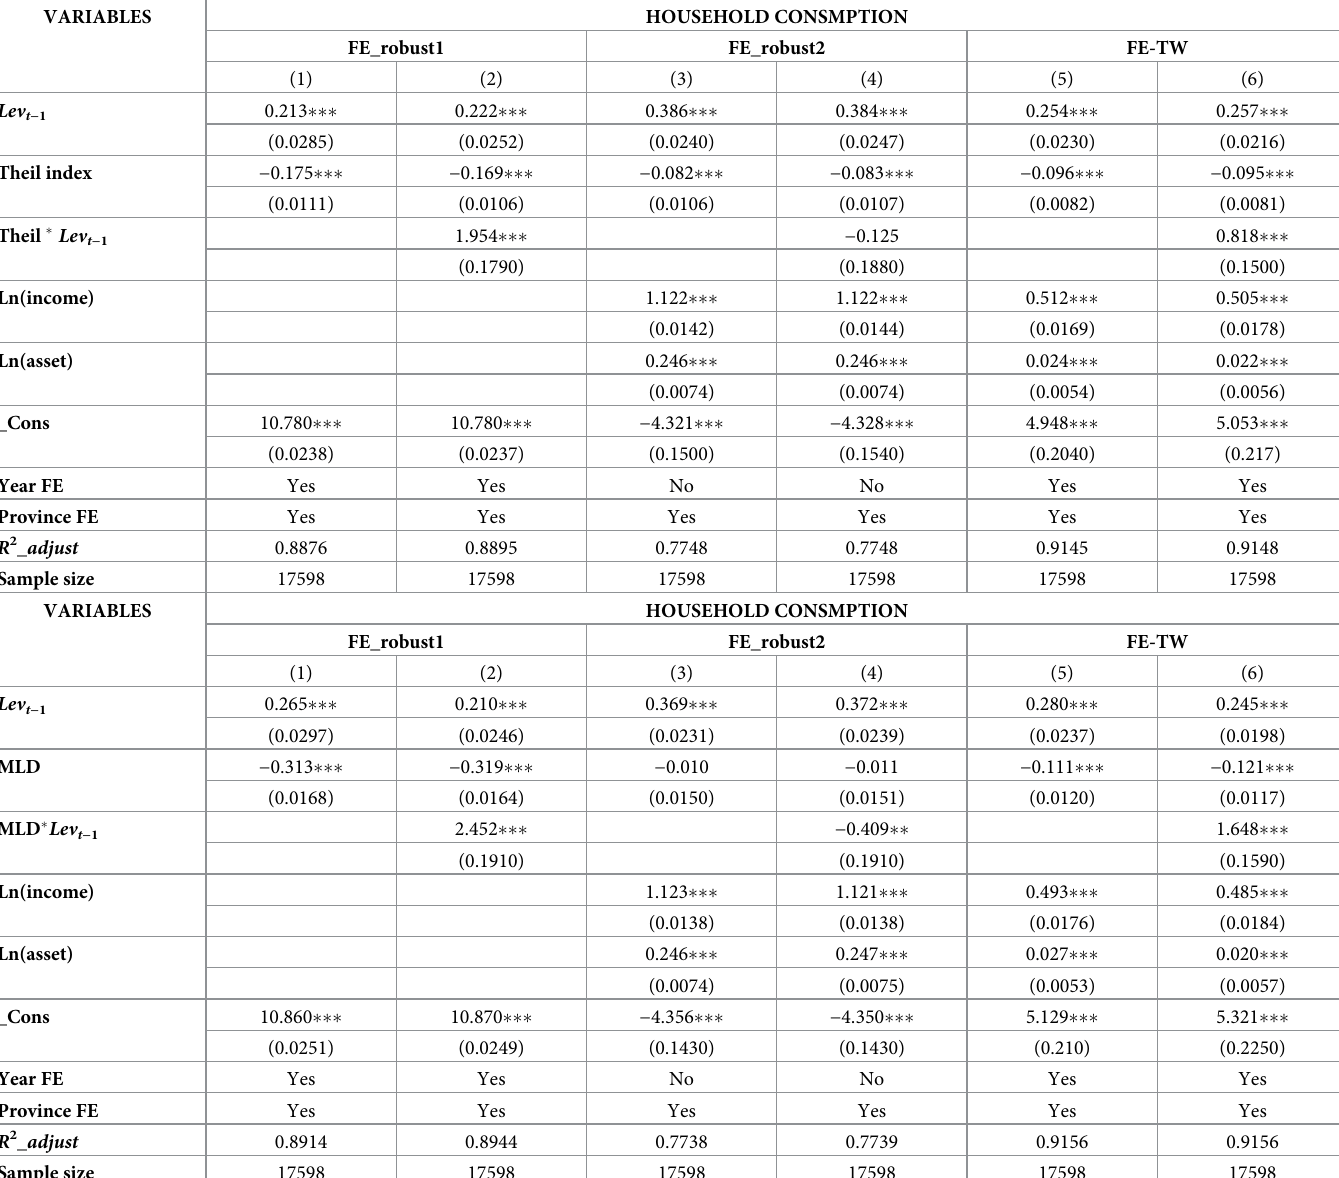
Table 6. Regression results of other measures of income